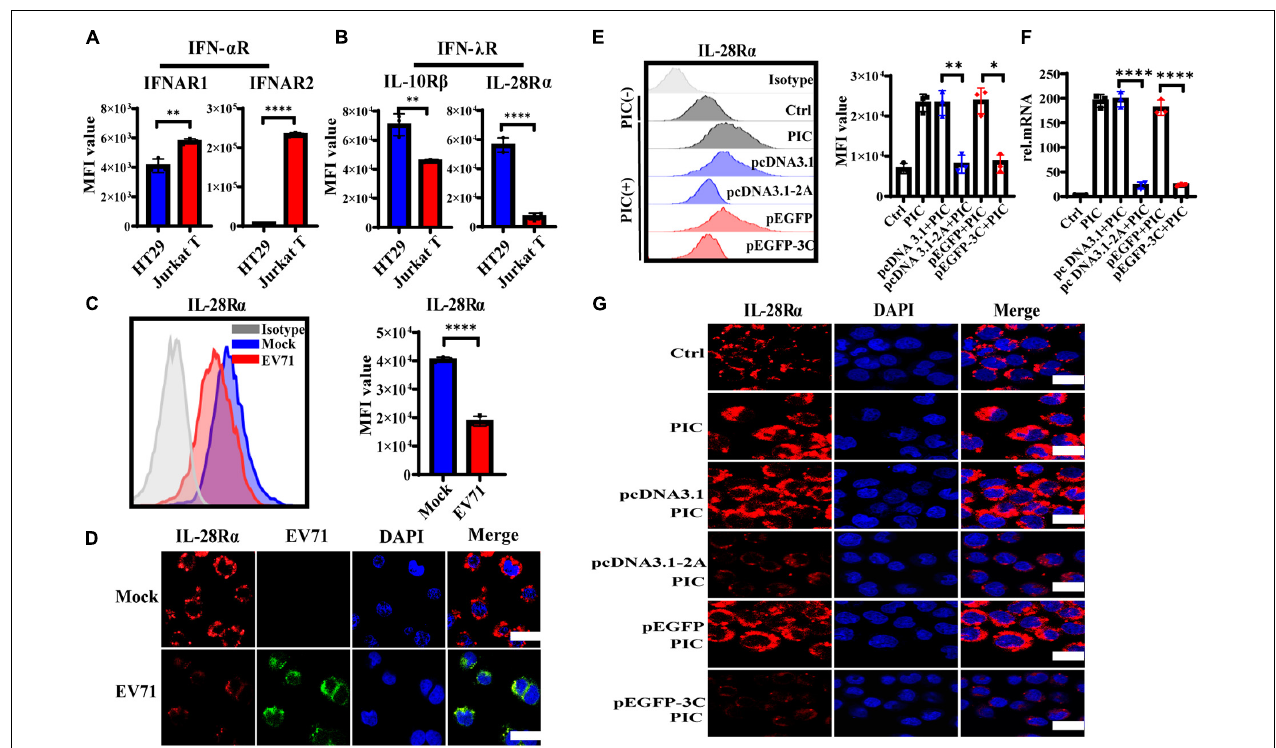
FIGURE 5 | The expression level of IFN- λ R on intestinal epithelial cells is inhibited by EV71, and its 2Apro and 3Cpro play an important inhibitory effect. (A) The expression levels of IFNAR1, IFNAR2, (B) IL-28R α , and IL-10R β on HT29 or Jurkat T were measured by FACS. (C) HT29 cells were infected with EV71 at an MOI of 1. The membrane expression level of IL-28R α was detected at 48 hpi by FACS. MFI, mean fluorescence intensity. (D) At 48 hpi, cells were fixed and stained with anti-EV71 (green) antibodies, anti-IL-28R α (red) antibodies, and DAPI (blue) and examined by a confocal microscope. Mock was cells without infection. Merged images of the different channels were shown. (E–G) HT29 cells were transfected with pcDNA3.1-2A (pcDNA3.1) or p-EGFP-3C (p-EGFP). After 24 h transfection, the cells were treated with PIC (4 µ g/ml) for another 24 h. Then cells were collected to detect the expression level of IL-28R α by FACS and IF, and the mRNA expression level was determined by qRT-PCR. Control was cells without any treatment. PIC group was cells stimulated only by poly(I:C). Dates were presented as mean ± SD ( n = 3 independent experiments, ∗ P < 0.05, ∗∗ P < 0.01 and ∗∗∗∗ P < 0.0001).